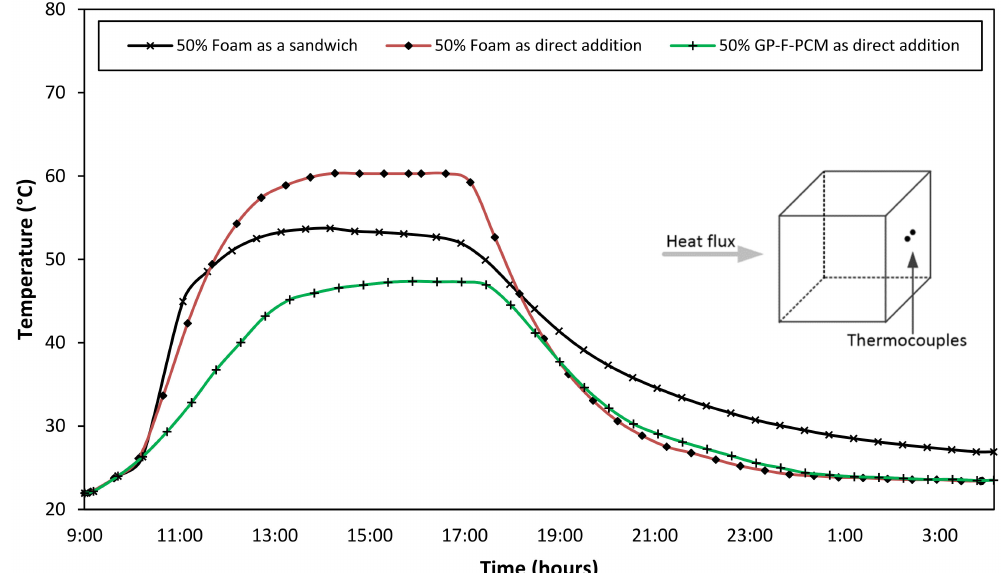
Figure 6. Back-surface temperature comparison of sandwich foam with the direct addition of foam and GP-F-PCM.